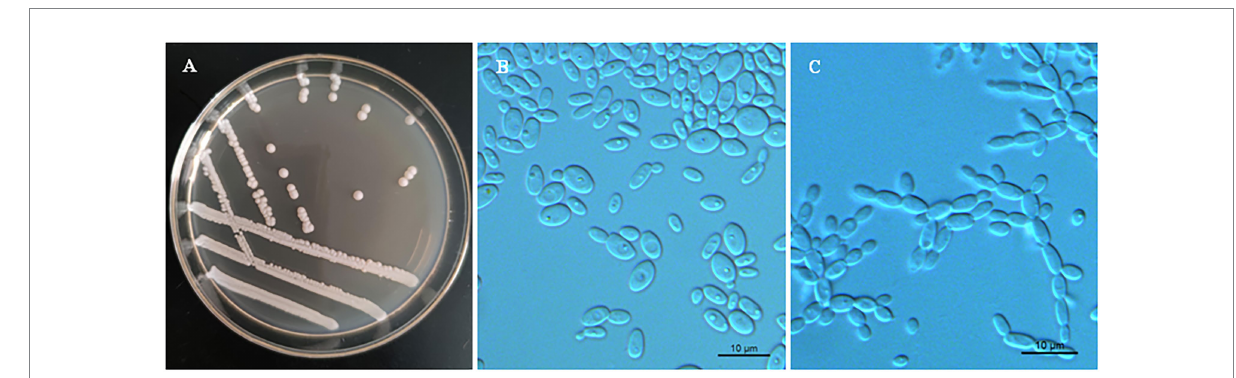
FIGURE 3 Morphological characteristics of Clavispora xylosa sp. nov. (CICC 33277, holotype). (A) Colony morphology on YM agar after growth for 3 days at 25 ° C. (B) Budding cells after growth for 3 d in YM broth at 25 ° C. (C) Pseudohyphae with blastoconidia on CM agar after growth for 7 days at 25 ° C. Scale bars = 10 μ